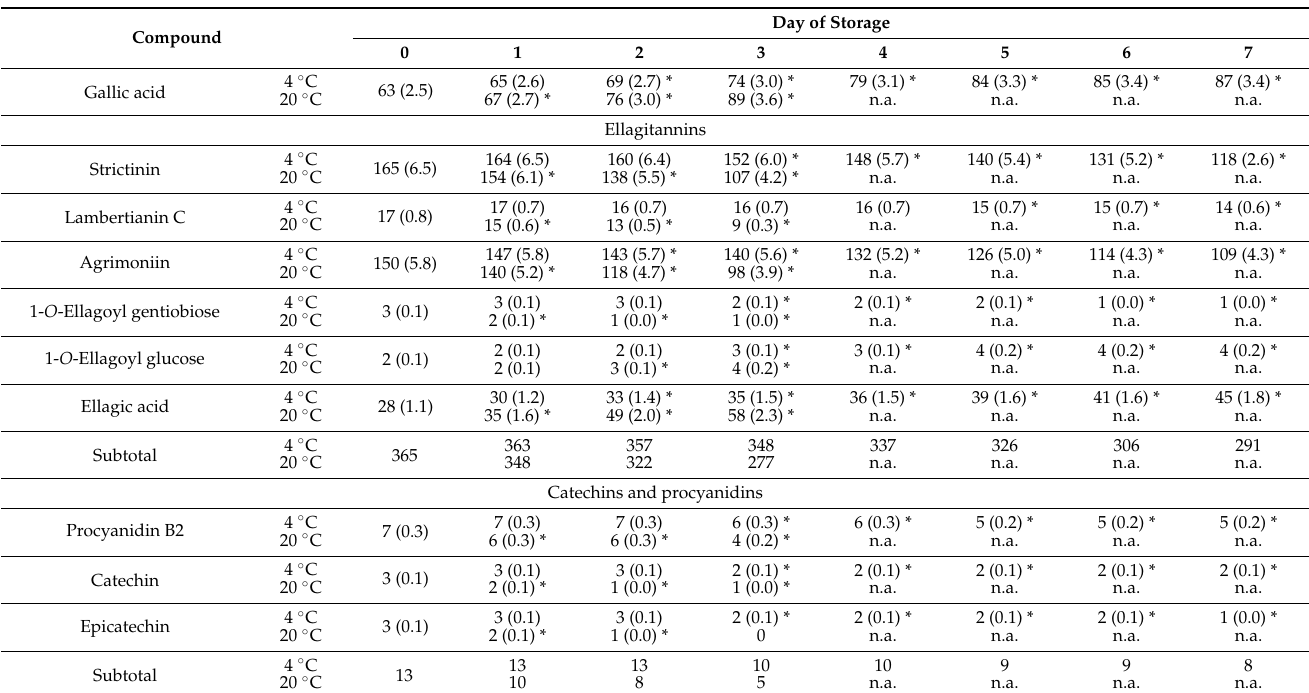
Table 4. Content of 20 phenolic compounds and ascorbic acid (mg/100 g fresh weight) and antioxidant potential ( µ mol trolox eq./100 g fresh weight) of F. orientalis fruits during storage at 4 ◦ C (7 days)